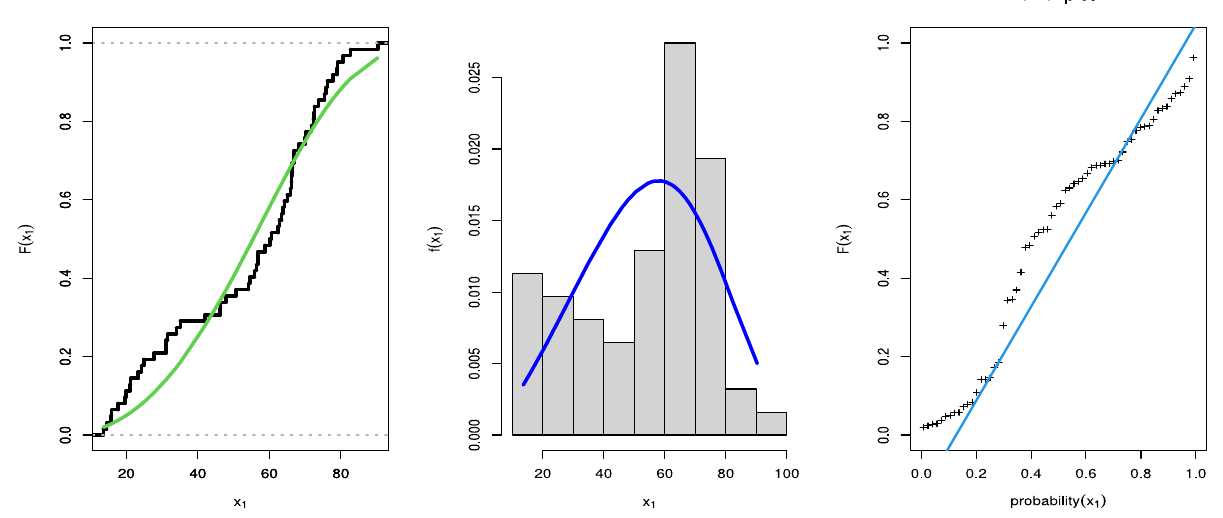
Table 7. MLE and Kolmogorov–Smirnov test for each stress level of real data.